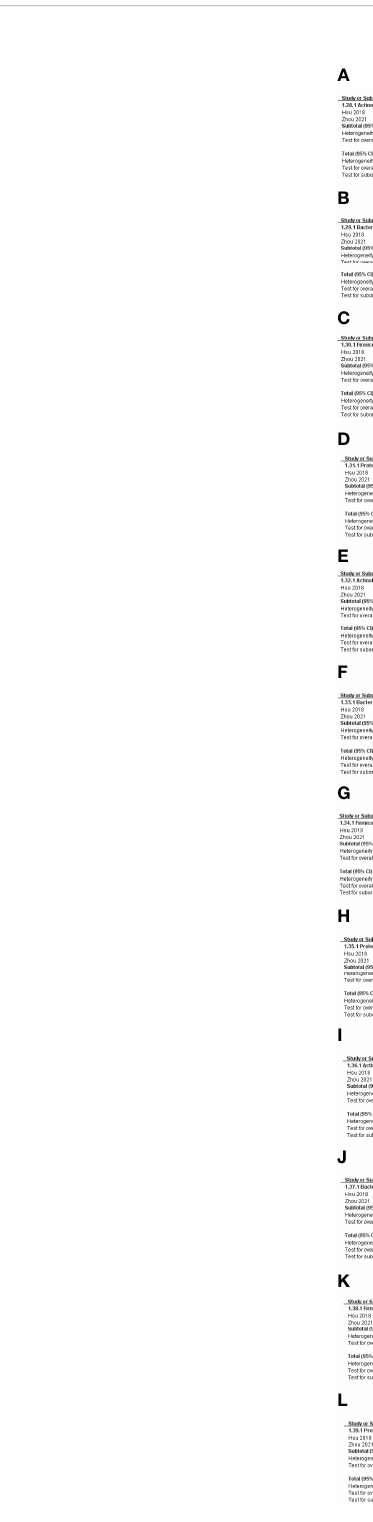
FIGURE 5 Comparison of results at different follow-up times after Bismuth-containing quadrupole therapy of H. pylori at the phylum level. (A – D) The alterations in gut microbiota within 7 days and 1 – 3 months after eradication treatment follow-up. (E – H) Alterations compared within 7 days and more than 6 months after eradication treatment follow-up. (I – L) Changes compared by 1 – 3 months and more than 6 months after eradication treatment